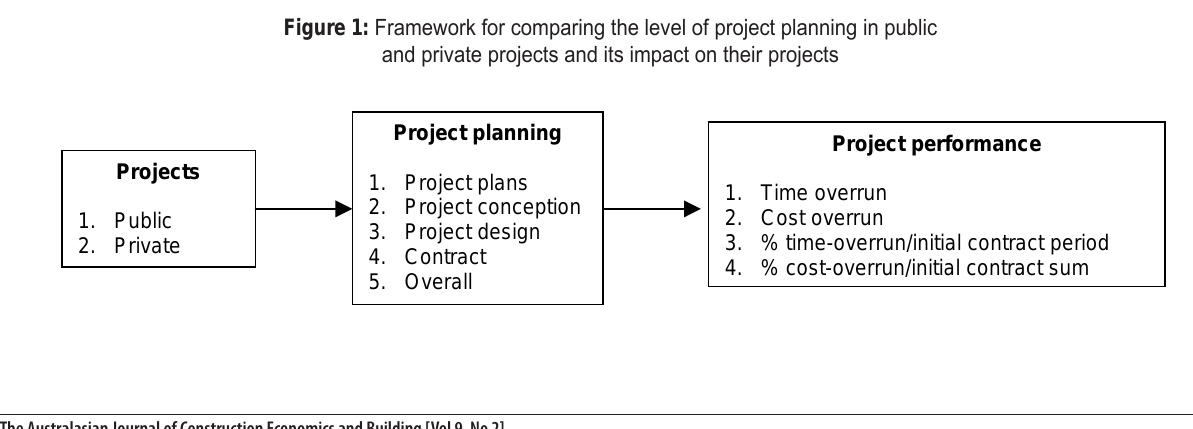
Figure 1: Framework for comparing the level of project planning in